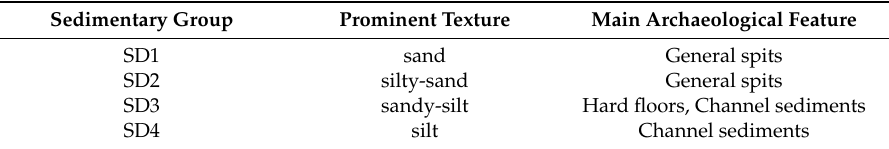
Table 2. Main Sedimentary groups identified in the study